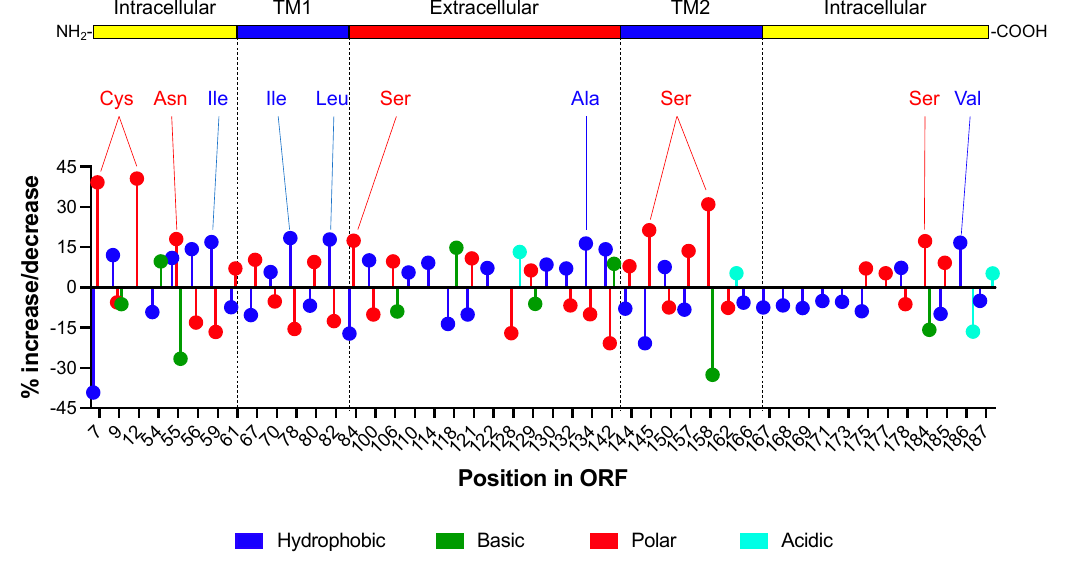
Figure 3. Evolution of the intact and interrupted asp ORFs. We assembled a set of 4362 sequences that contained an intact asp ORF that was able to express a protein >150 aa, and a set of 2260 control sequences where the asp ORF was interrupted by internal stops. The asp ORFs in both datasets were translated into proteins and then we compared the amino acid content in accordance with four functional classes: hydrophobic (Ala, Ile, Leu, Met, Phe, Pro, Trp, Val), polar (Asn, Cys, Gln, Gly, Ser, Thr, Tyr), basic (Arg, His, Lys), and acidic (Asp, Glu) using the contingency-table χ 2 test [42]. In the case of a χ 2 value above the cut-off of significance, we selected only the amino acid positions where functional amino acids (internal stop codons in the control set were excluded from the analysis) showed an enrichment that was higher than 5% or a depletion that was lower than –5%. Following the identification of the positions with a significantly higher/lower content of a given class of amino acids, we again used the χ 2 test to identify the specific amino acid(s) within that class with enrichment that was higher than 5% or depletion that was lower than − 5% in ASP that was encoded by intact ORFs. The figure reports the percent enrichment or depletion of hydrophobic (blue bars), polar (red bars), basic (green bars), and acidic (aqua bars) amino acids in ASP that was encoded by intact ORFs compared to interrupted ORFs. Residues that were enriched more than 15% are indicated above the graph. Superimposition of the linear map of ASP allows the localization of each enriched/depleted amino acid with respect to the major functional domains of the protein.